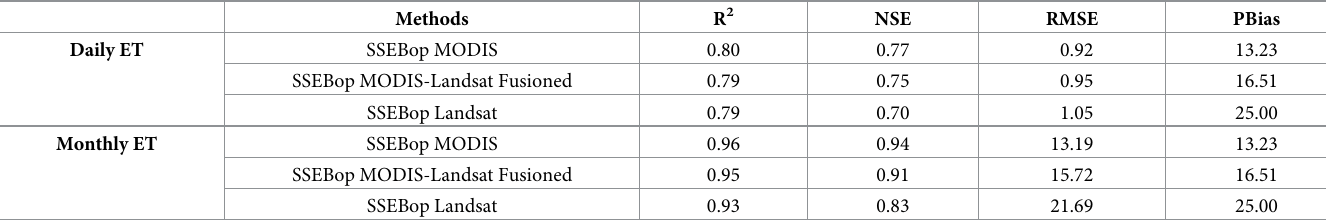
Table 1. The overall performance statistics of daily and monthly ET estimations using different